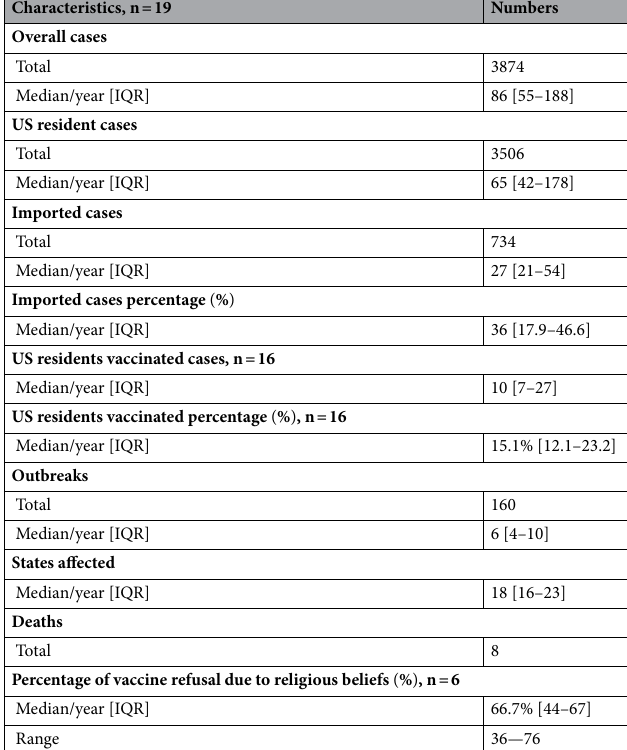
Table 1. Clinical characteristics of measles cases between 2001 and